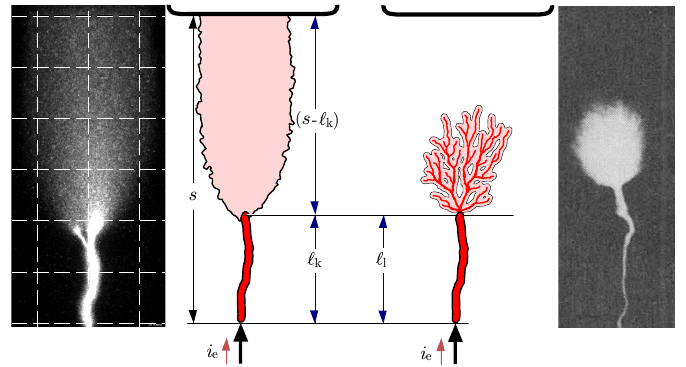
Figure 7. ( Left ): conductive canal and backward wave during LI-breakdown—( Right ): leader discharge and streamer head during SI-breakdown. Figure out of [24].